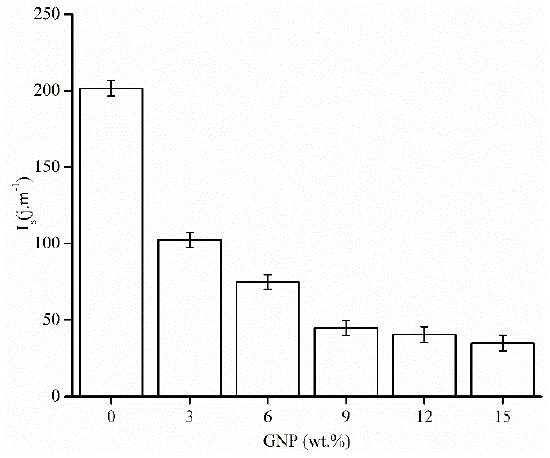
Figure 7. Izod impact strength versus GNP concentration in the composites.